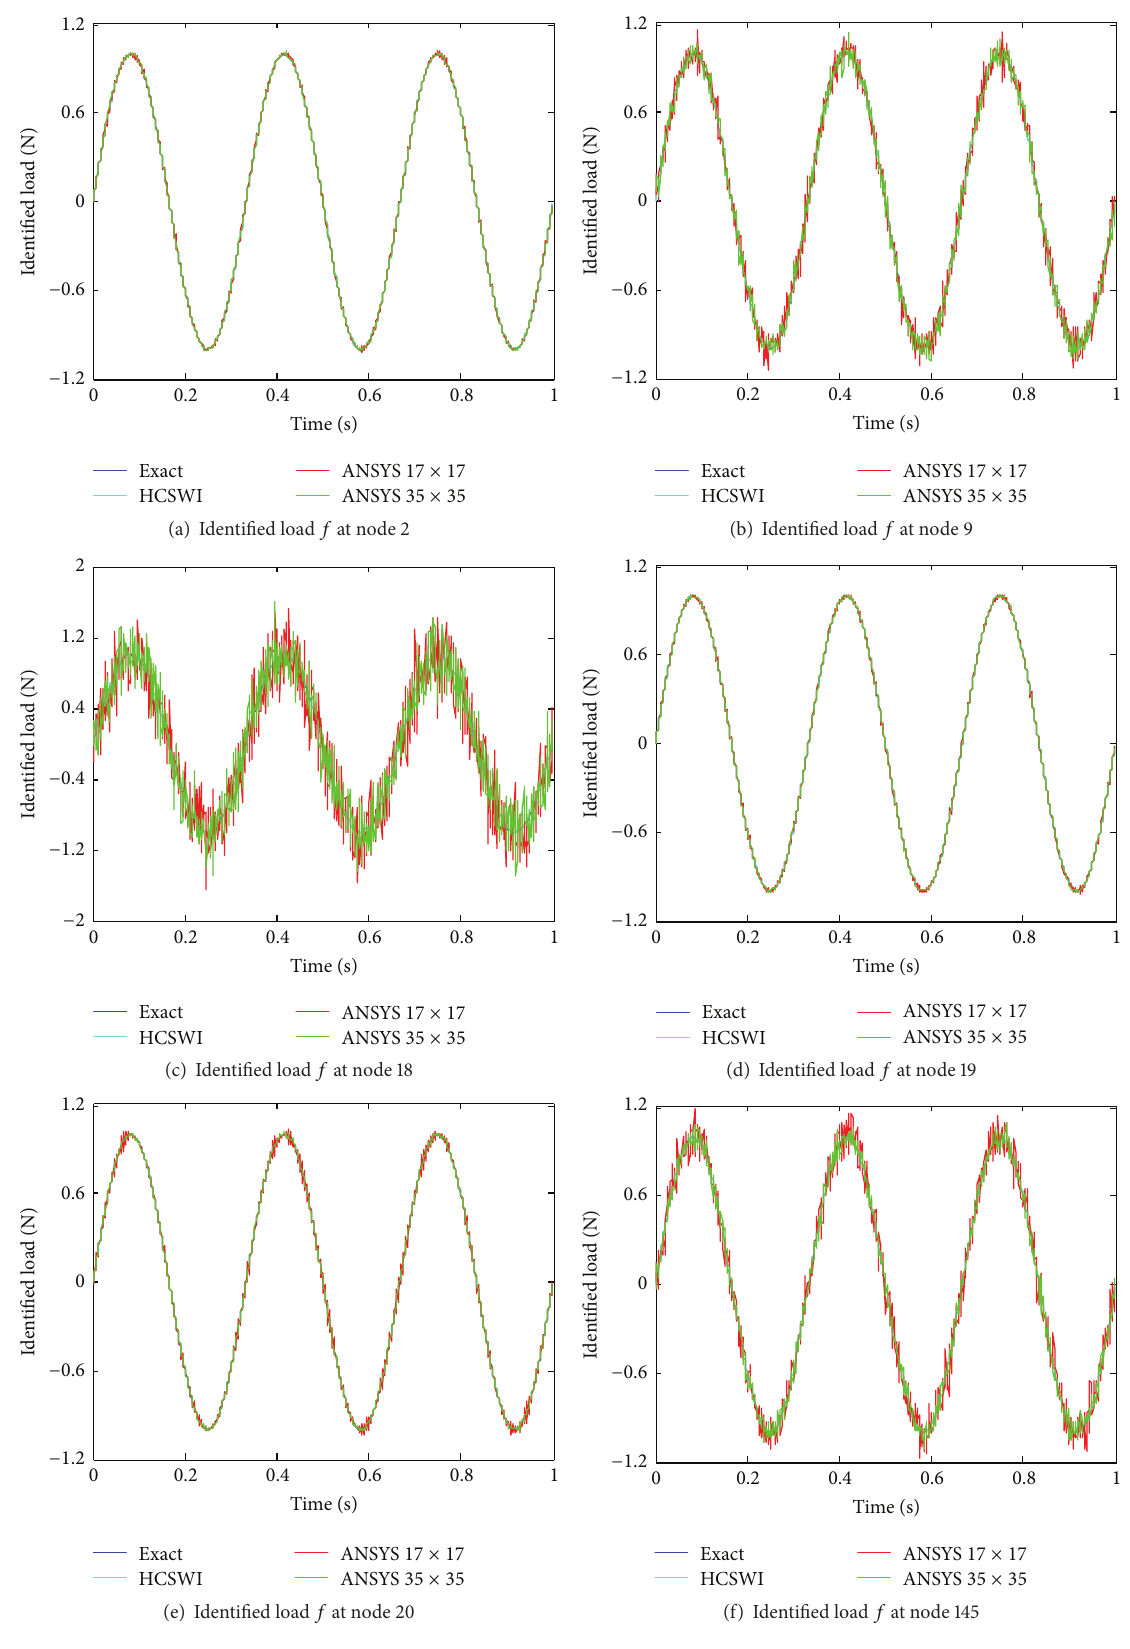
Figure 8: Load identification at different nodes with excitation 𝑓 applied at node